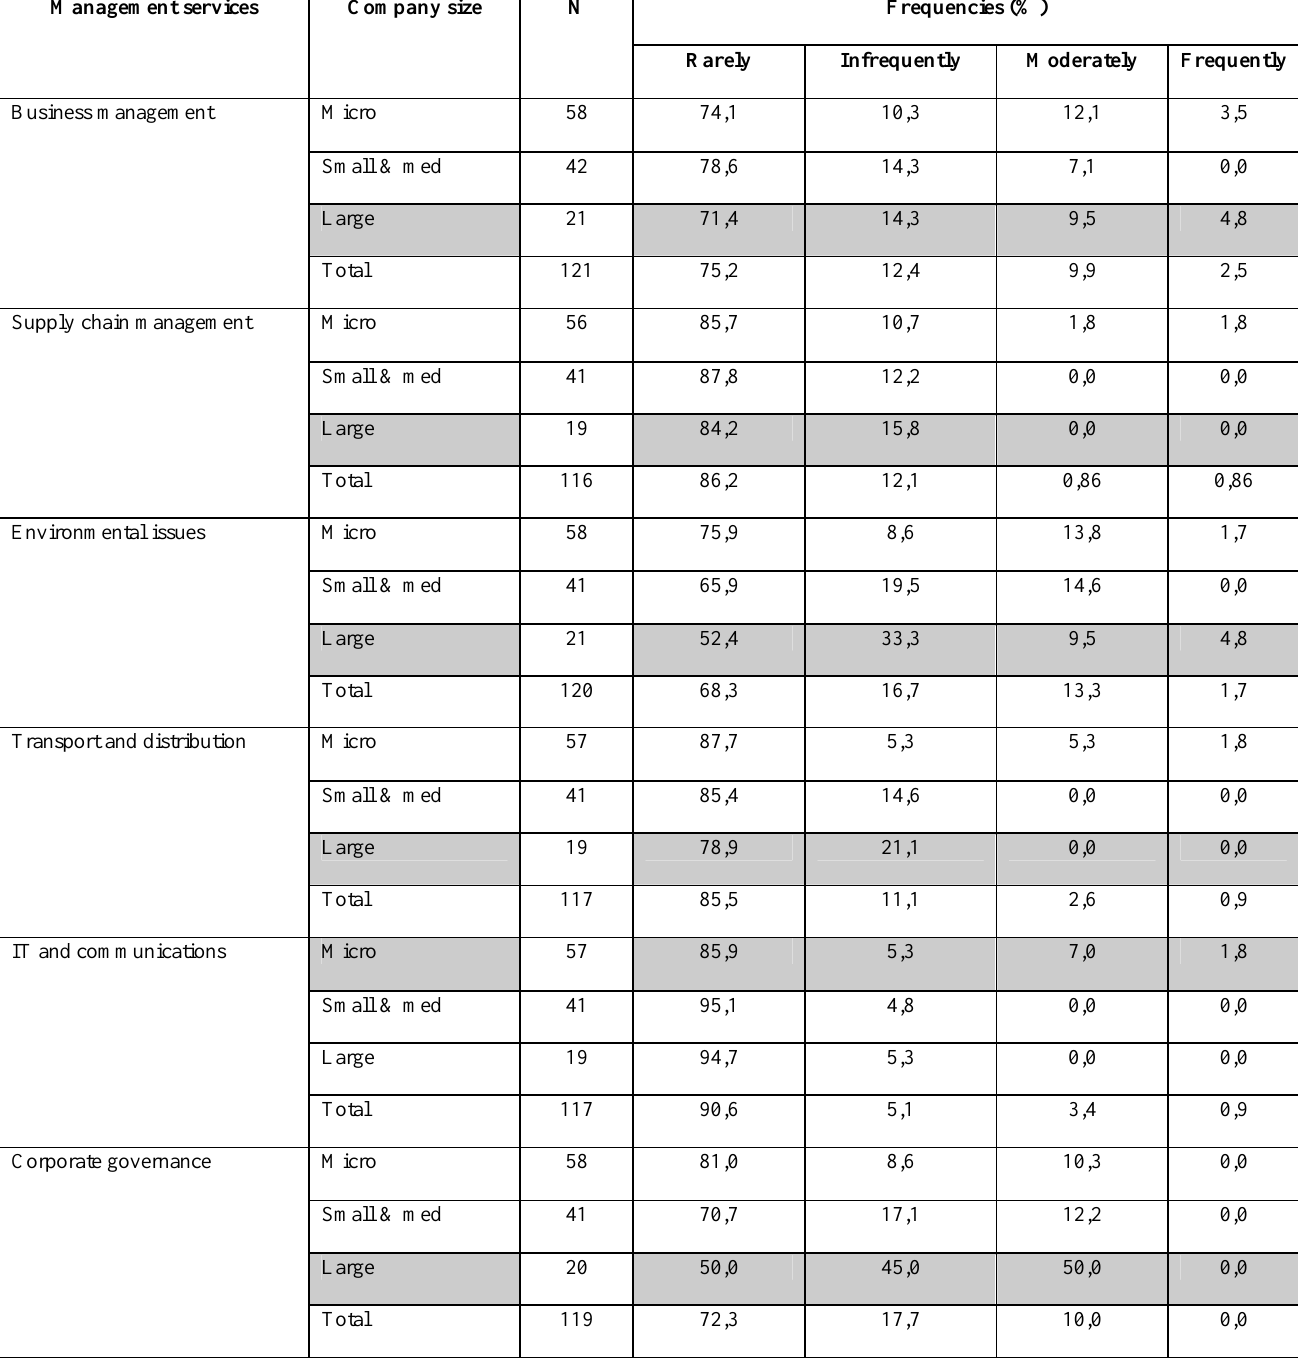
Table 4: Comparison between company size and responses to management services Management